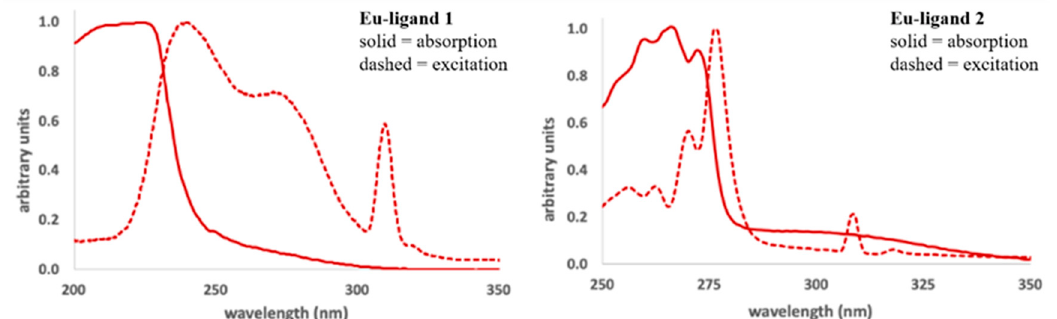
Figure 6. Absorption (solid line) and excitation (dashed line) spectra for the ( left ) Eu(NO 3 ) 3 ( 1 ) and ( right ) Eu(NO 3 ) 3 ( 2 ) complexes in acetonitrile (1.0 mM complex concentration, emission wavelengths were monitored at 620 nm for the complex with ligand 1 , and 617 nm for the complex with ligand 2 , 2.0 nm excitation and emission slit widths). Note that the intensity values of all the spectra shown here have been normalized to have their λ max equal one (1.0) for ease of comparison.